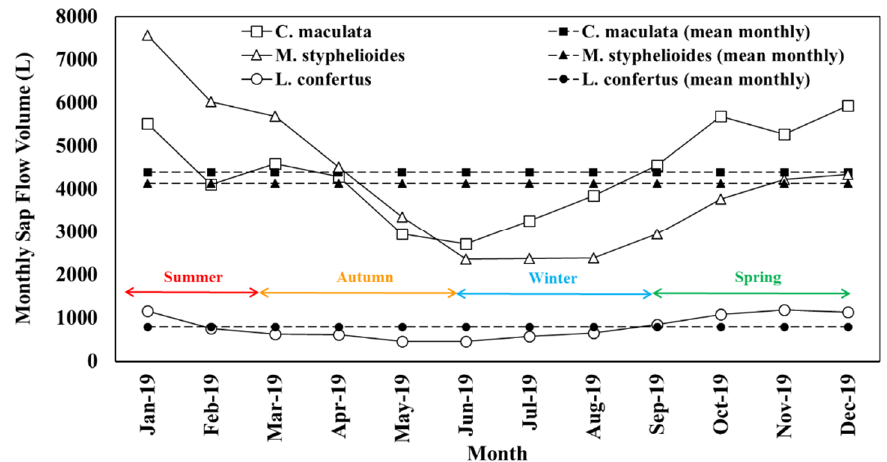
Figure 9. Monthly sap flow volume variation for the C. maculata , M. styphelioides and L. confertus used in these experiments.